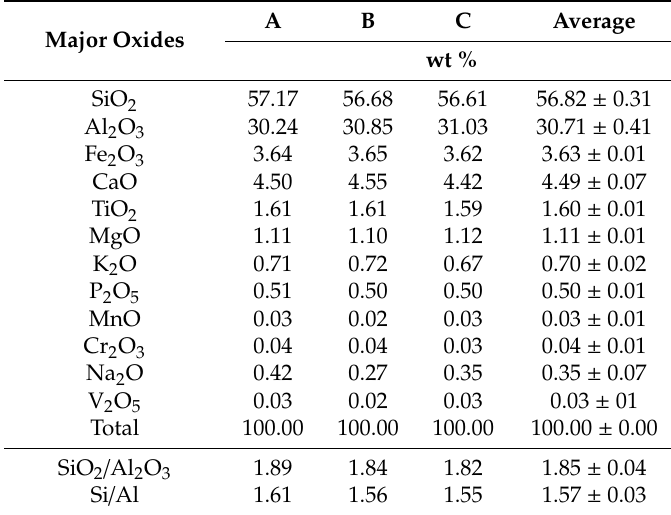
Table 4. Distribution of fresh coal fly